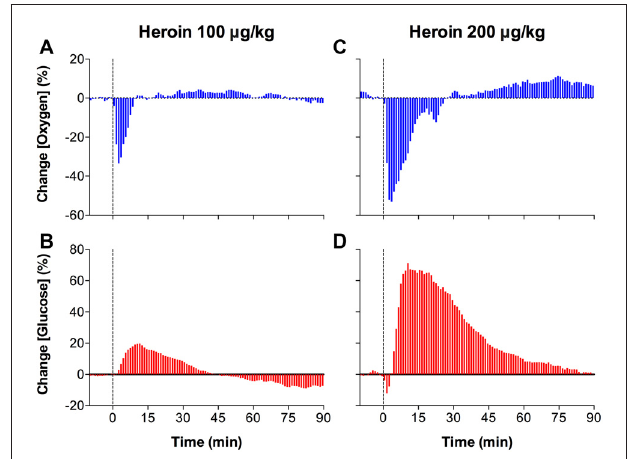
FIGURE 5 | Mean ( ± SEM) changes in NAc levels of oxygen (A,C) and glucose (B,D) induced by intravenous heroin injections at two low doses. Data are analyzed with slow, 1-min time resolution and are expressed in percent vs. pre-injection baseline (= 0). Vertical dotted lines show the onset of injection. Original data were published in Solis et al. (2017c).